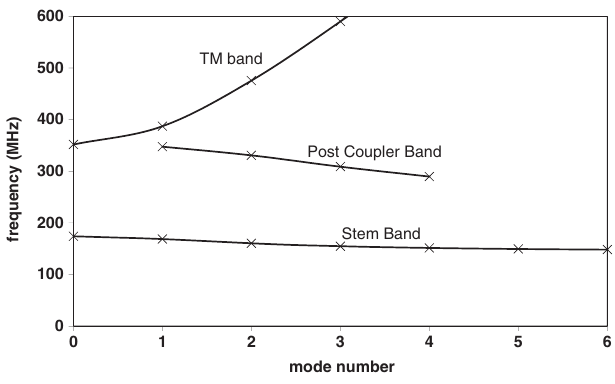
FIG. 12. Equivalent circuit for a DTL including DT, stem, and PC resonators.